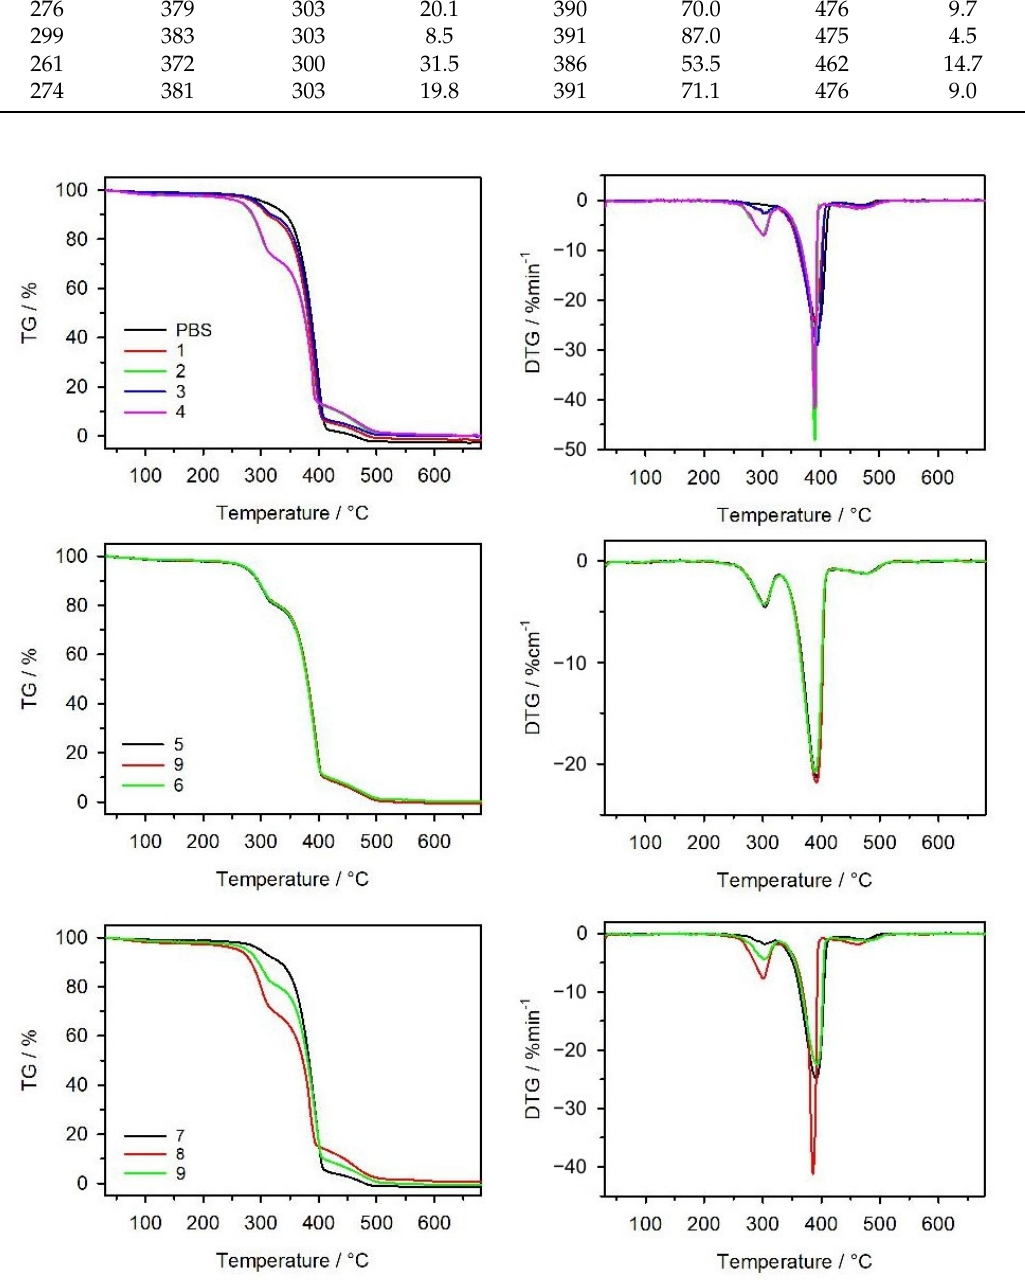
Figure 11. TG and DTG curves of PBS and its biocomposites with bran.